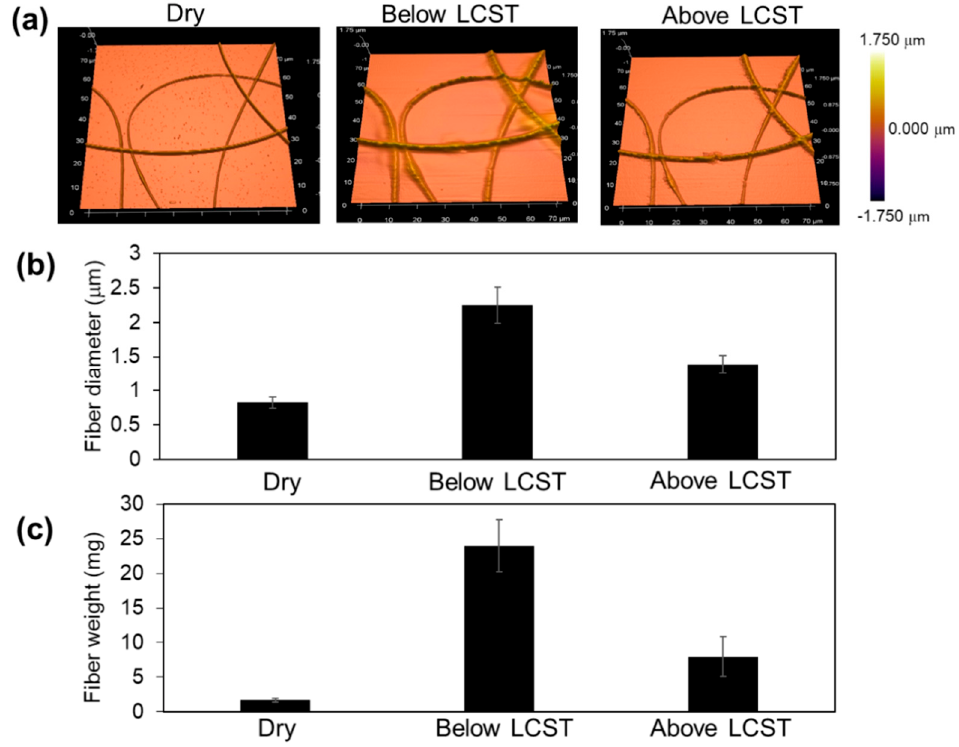
Figure 5. ( a ) AFM images, ( b ) the corresponding fiber diameters, and ( c ) fiber weights at dry state (left), at swollen state in water below the LCST (middle), and at dehydrated state above the LCST